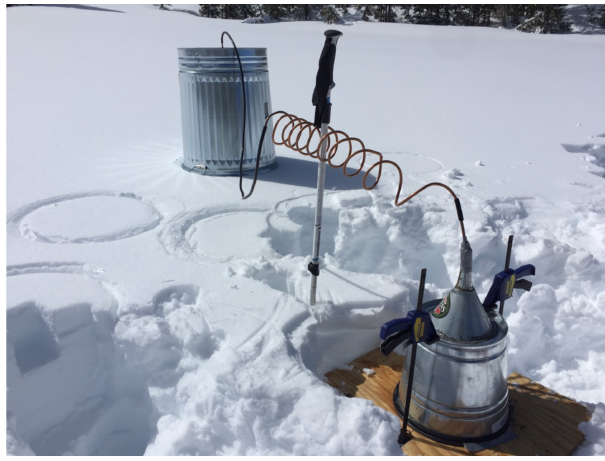
Figure 3. Use of the apparatus at the Tamarack Lake site for de- positing BC